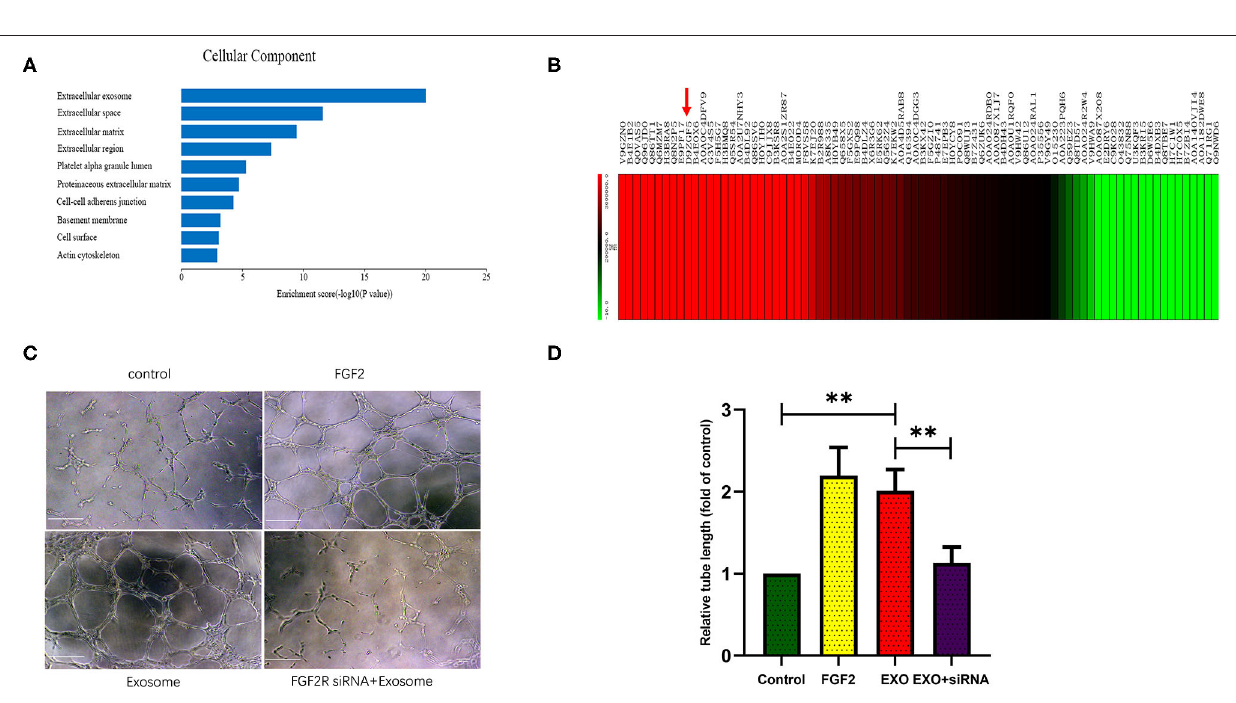
FIGURE 2 | ESCs-derived exosomes stimulate angiogenesis in a FGF2 related way. (A,B) Proteome analysis showed ESCs-derived exosomes contains hundreds of proteins in which FGF2 was high abundant and ranked in the top ten of all the proteins in the exosomes. (C,D) Exosomes treated HUVECs formed greater tube length compared with control group. FGF2R siRNA interference impaired the exosomes induced angiogenesis in vitro (scale bar, 100 um). * p < 0.05, ** p <